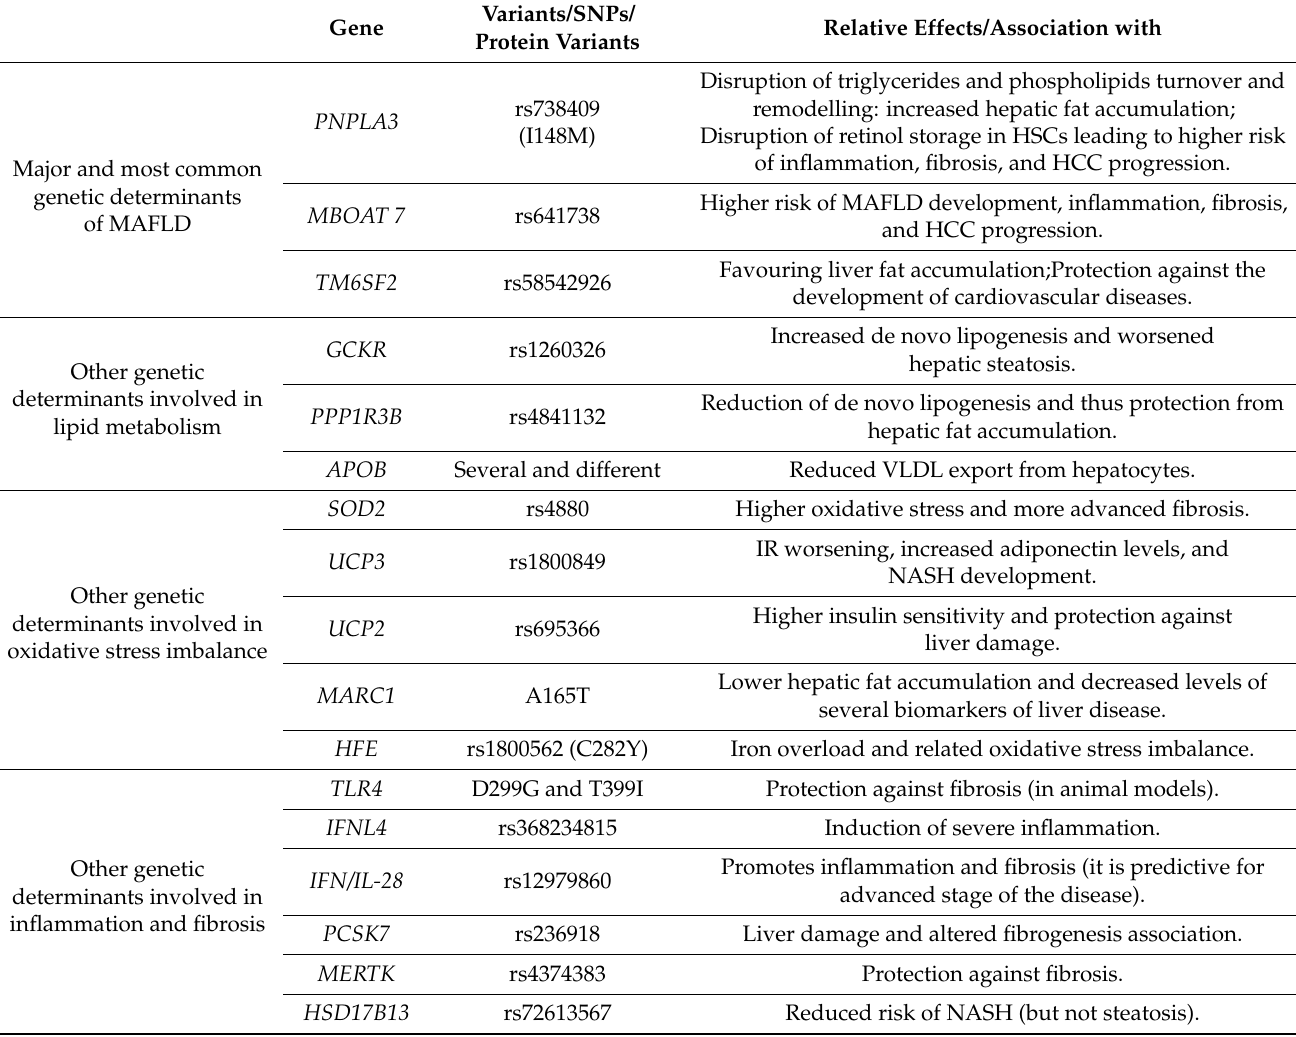
Table 1. Main genetic determinants of